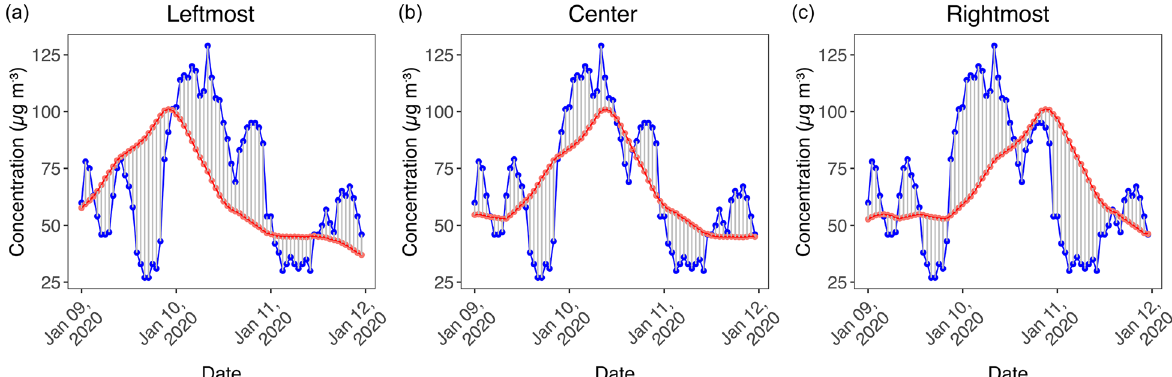
Fig. 4 Distance between hourly PM 2.5 concentrations measured at station 02 T and its 24-h average PM 2.5 concentrations recorded at leftmost, center, and rightmost, respectively. Blue color represents hourly time series data, red color represents 24-h moving average time series data, and gray color is point to point